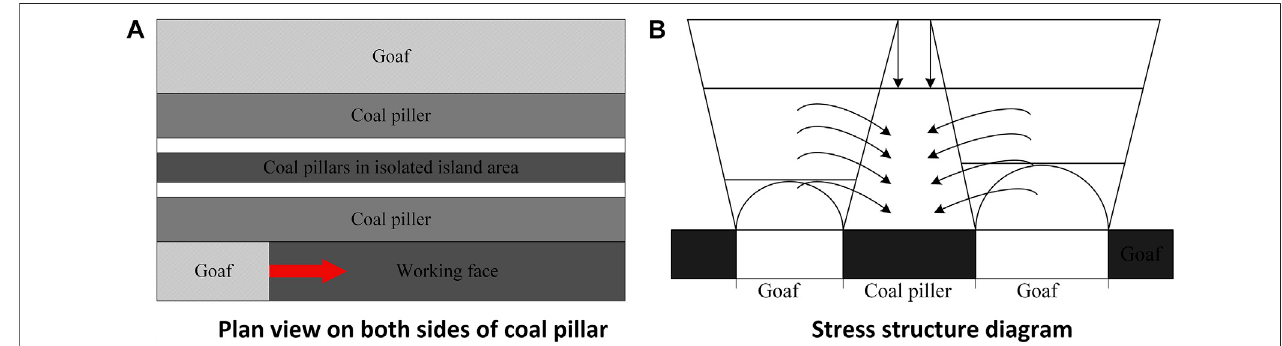
FIGURE9 | Distributioncharacteristics ofsuperimposed stress fi eld after the formationof thegoaf on both sidesof thecoal pillar island area. (A) Planviewon both sides of coal pillar, and (B) Stress structure diagram